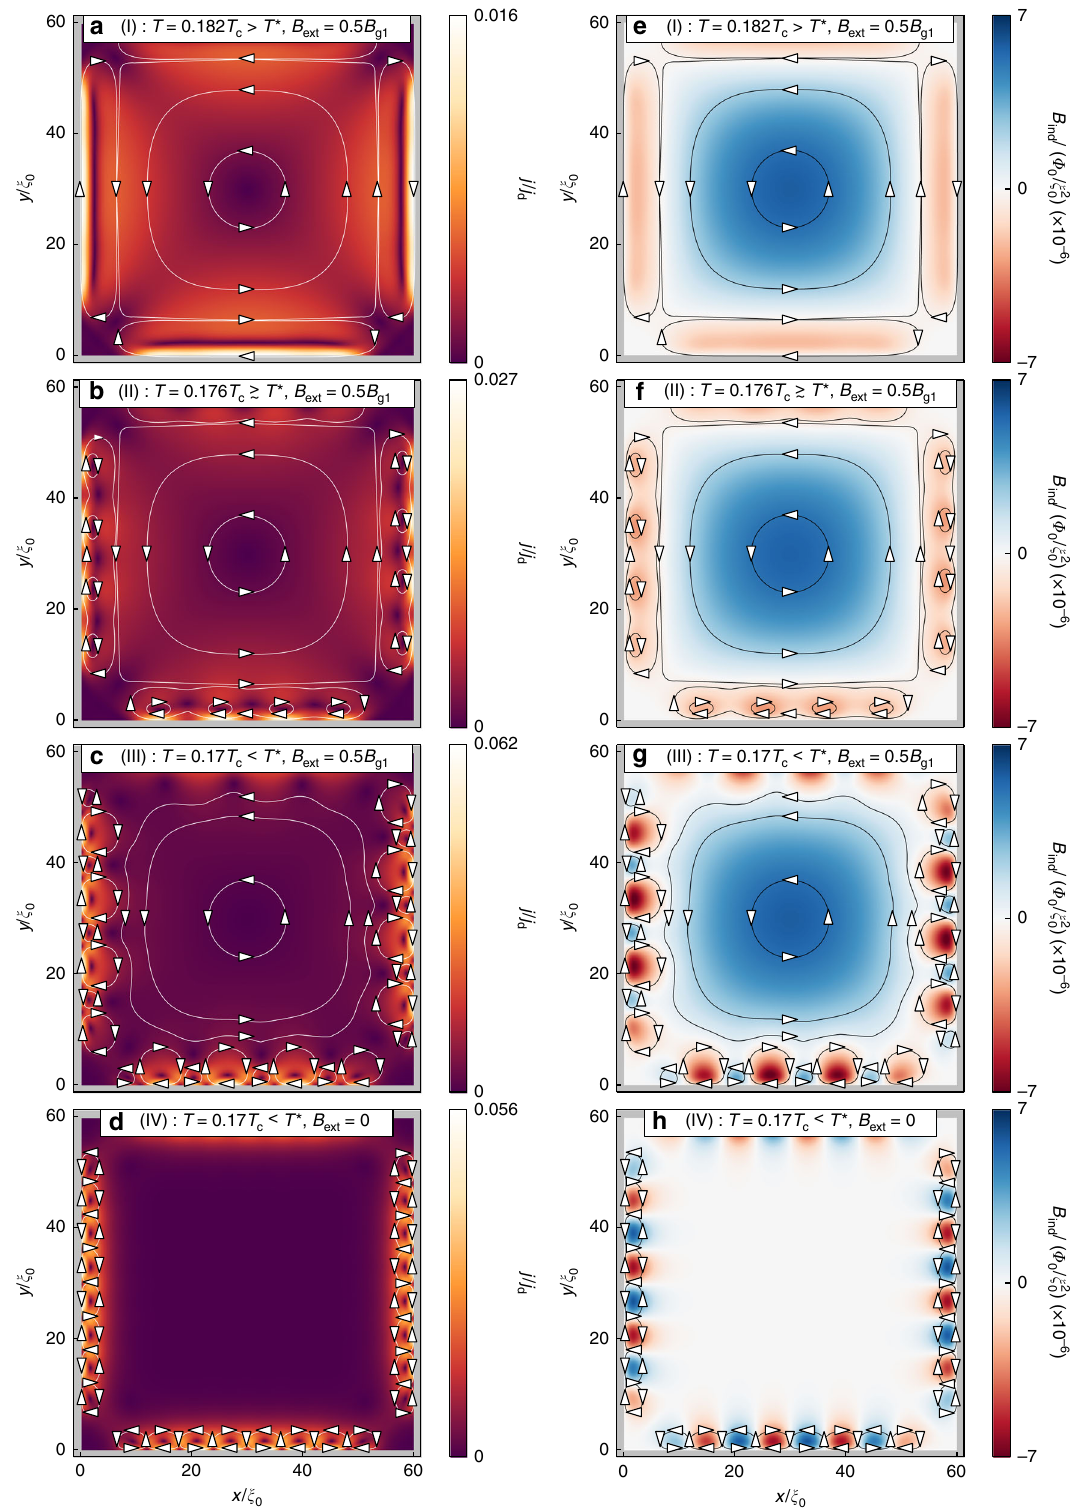
Fig. 2 Spontaneously formed currents and induced magnetic fi eld. a – d Total current magnitude and e – h induced magnetic fl ux density for different temperatures and external fi elds (see annotations). Lines and arrows have been added to illustrate the fl ow of the